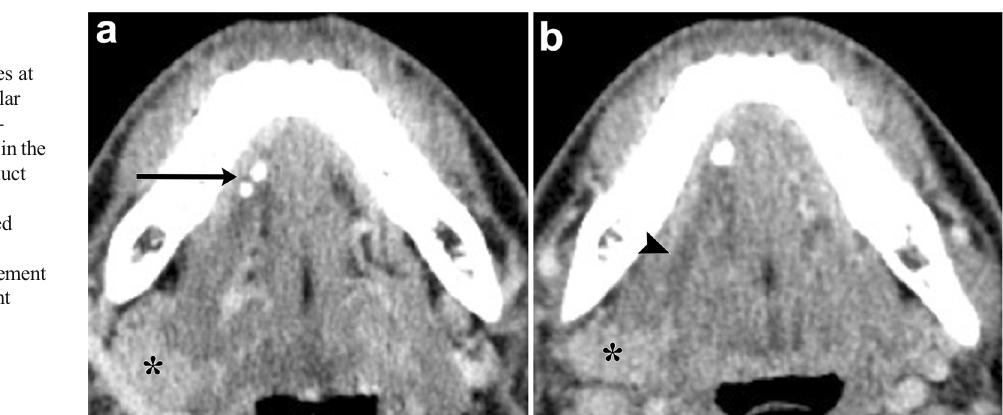
Fig. 10 Sialolithiasis with resultant sialadenitis. Axial contrast-enhanced CT images at the level of the submandibular gland demonstrate two well- circumscribed calcifications inthe distal right submandibular duct ( a , arrow ). The right submandibular duct is dilated proximal to the stones ( b , arrowhead ). There is enlargement and enhancement of the right submandibular gland (*) compared to the normal left submandibular gland